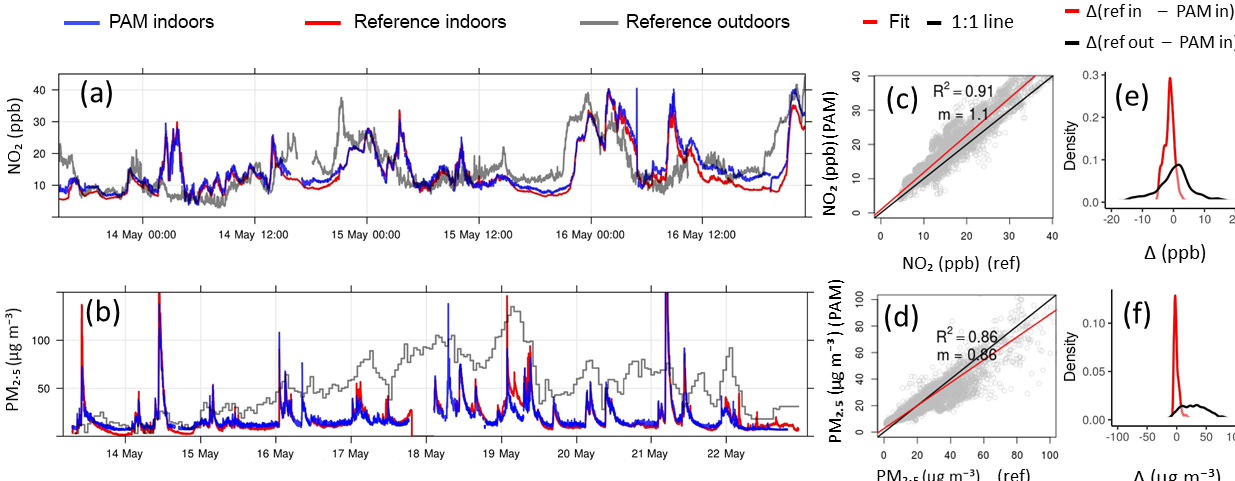
Figure 4. Indoor co-location of a PAM with portable commercial instrumentation (Table 2) in an urban flat in China during the non-heating season. (a) Time series of NO 2 from the PAM (blue) and a cavity attenuated phase shift spectroscopy (CAPS) instrument (red). Outdoor NO 2 measurements (grey) were collected at a PKU reference site (Table 2), which was located 5.3km away. Time resolution of measurements is 1min. (b) Time series of PM 2 . 5 mass measured with the PAM (blue) next to a commercial portable spectrometer (GRIMM 1.108, red). Mass concentrations were calculated from particle counts within the size range 0.38–17µm with the same aerosol density for both instruments. Outdoor PM 2 . 5 mass measurements (grey) were collected at the closest governmental station (Table 2, 1h time resolution), which was located